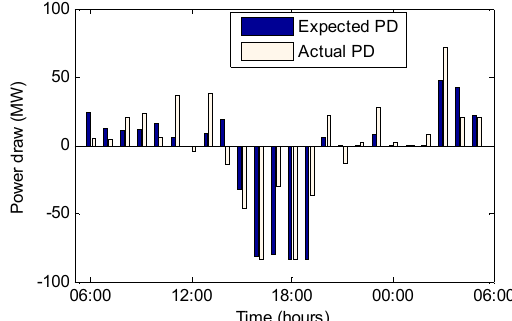
Figure 12. Expected and actual power draw of the energy storage unit at 2 August 2010.